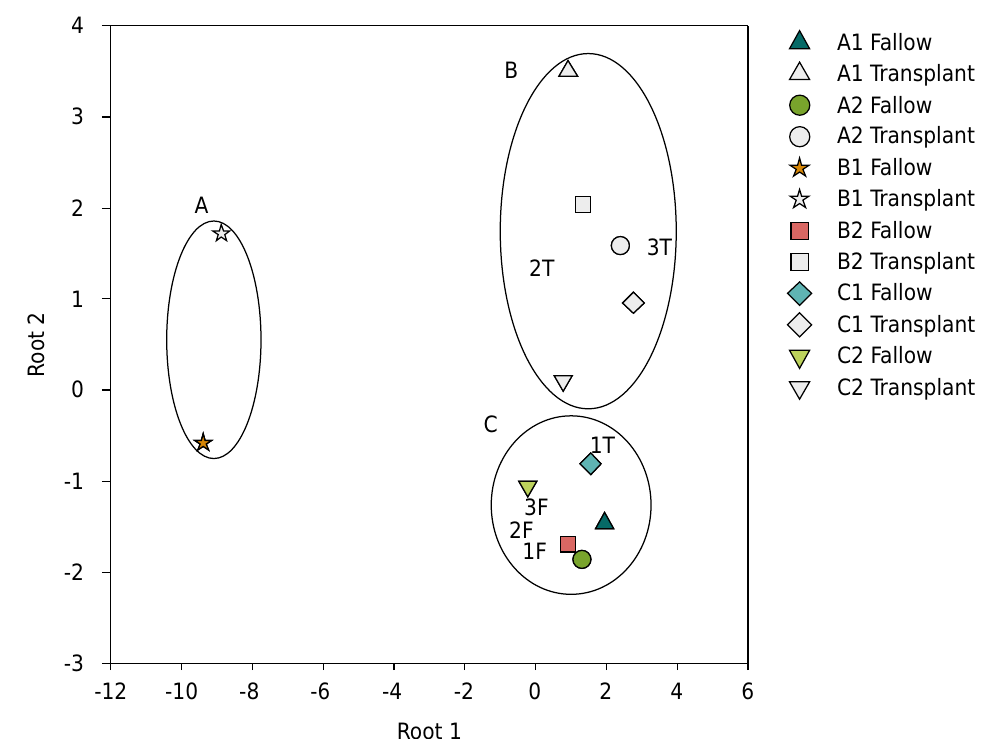
Figure 5. Two-dimensional scatter plot of the first and second discriminant functions from stepwise Discriminant Function Analysis (DFA) using P forms in suspended sediment collected upstream and downstream in the Sub-basins A, B, and C, and during rising limb (1), peak discharge (2), and recession limb (3) at the catchment outlet, in two storm events occurred in the periods of fallow (F) and tobacco transplantation (T), in Agudo catchment, Rio Grande do Sul, Brazil.